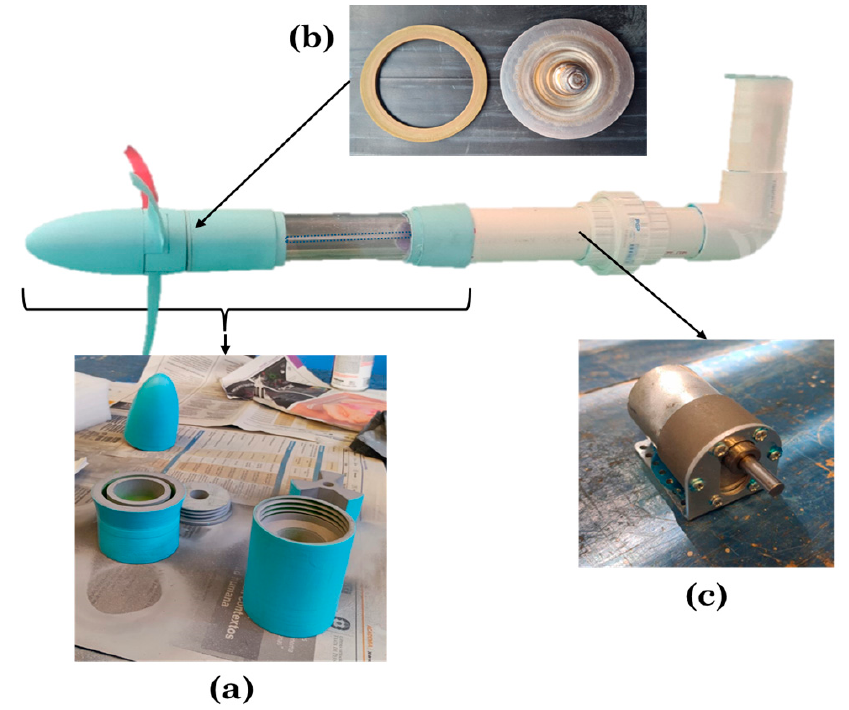
Figure 8. Components of the marine turbine model: ( a ) PLA components, ( b ) Blender blade mecha- nism and rubber seal, ( c ) Gear motor.